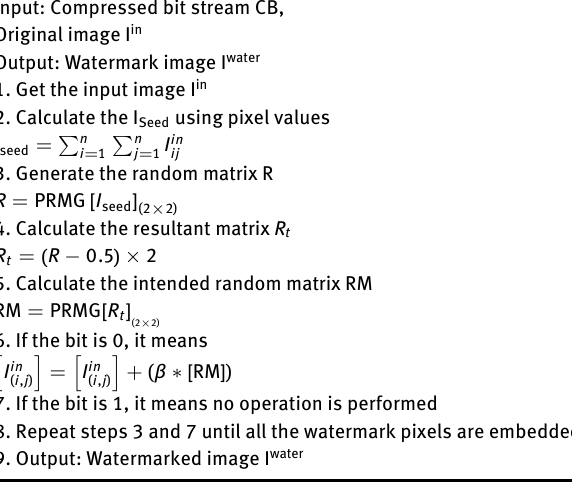
Table 2: Embedding